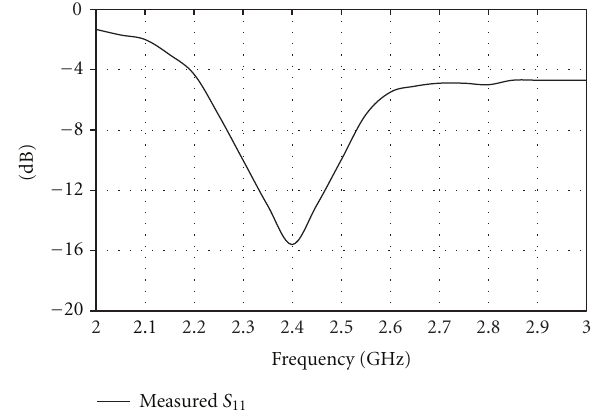
Figure 7: Measured return loss of the dipole antenna with reflector and